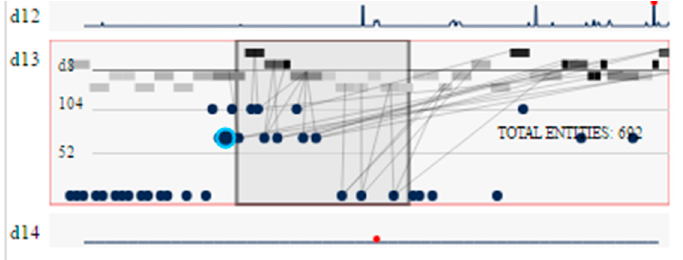
Figure 27. Using the magic lens to inspect a set of ontology entities and their inheritance